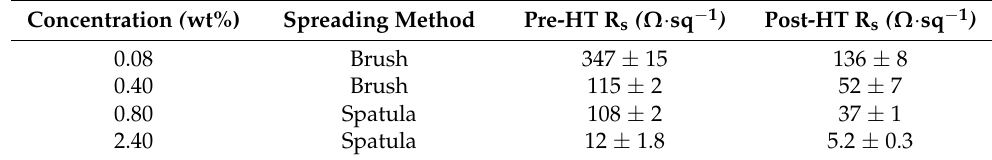
Table 1. Sheet resistance values before and after HT for four concentrations of the ink